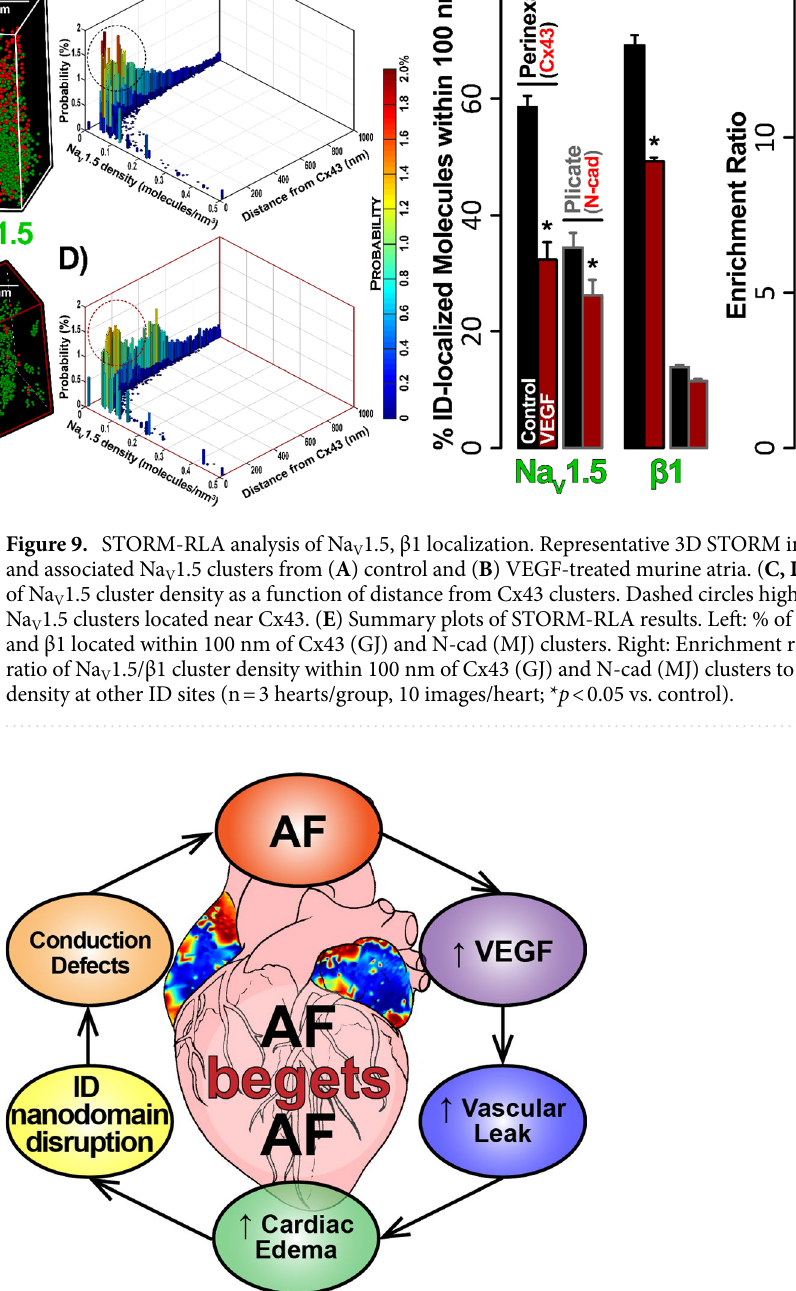
inflammatory response (90 min of exposure to pathophysiological levels of TNFα) 21 . Consistent with these, our